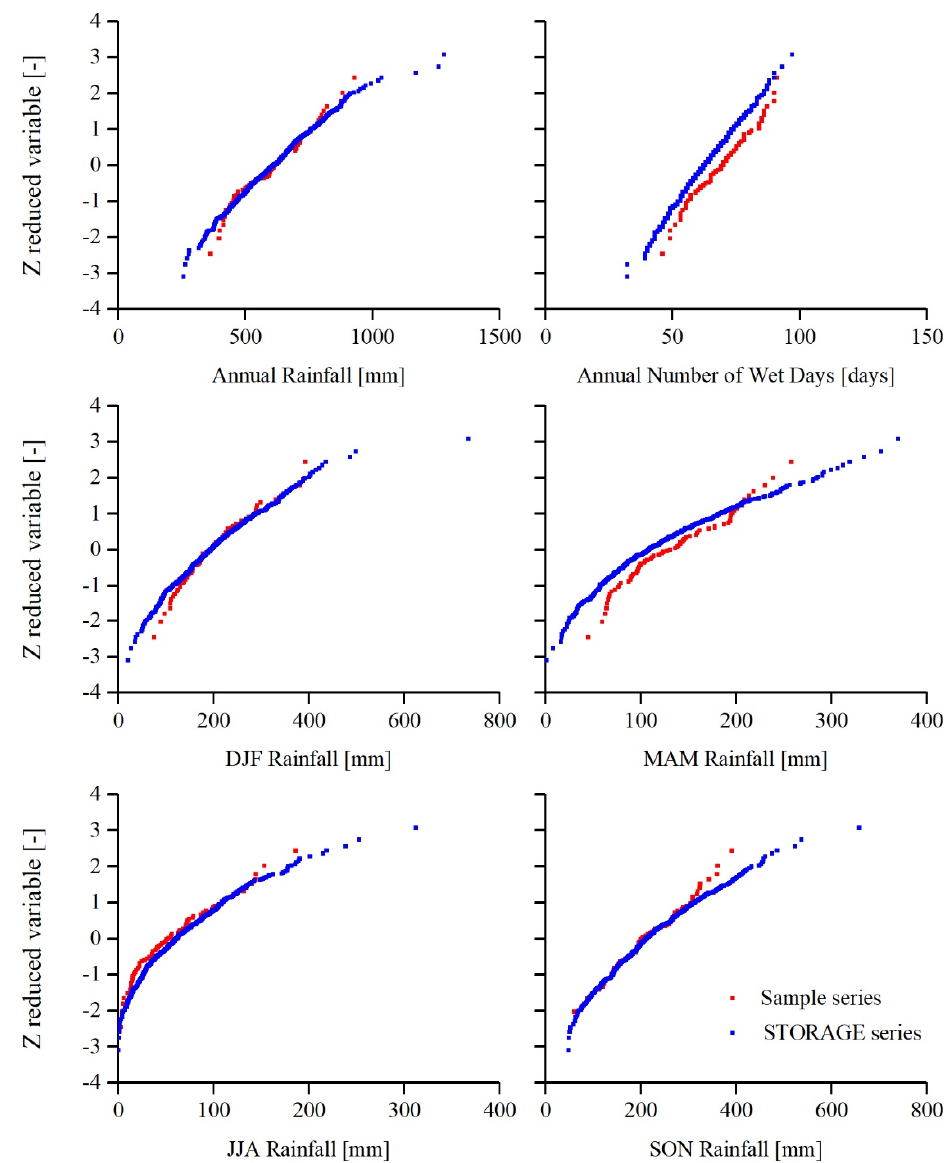
Figure 3. Brindisi rain gauge: Gaussian probabilistic plots, showing the comparison among synthetic and observed series, regarding annual and seasonal rainfall, and annual number of wet days (under the hypothesis of stationary process).